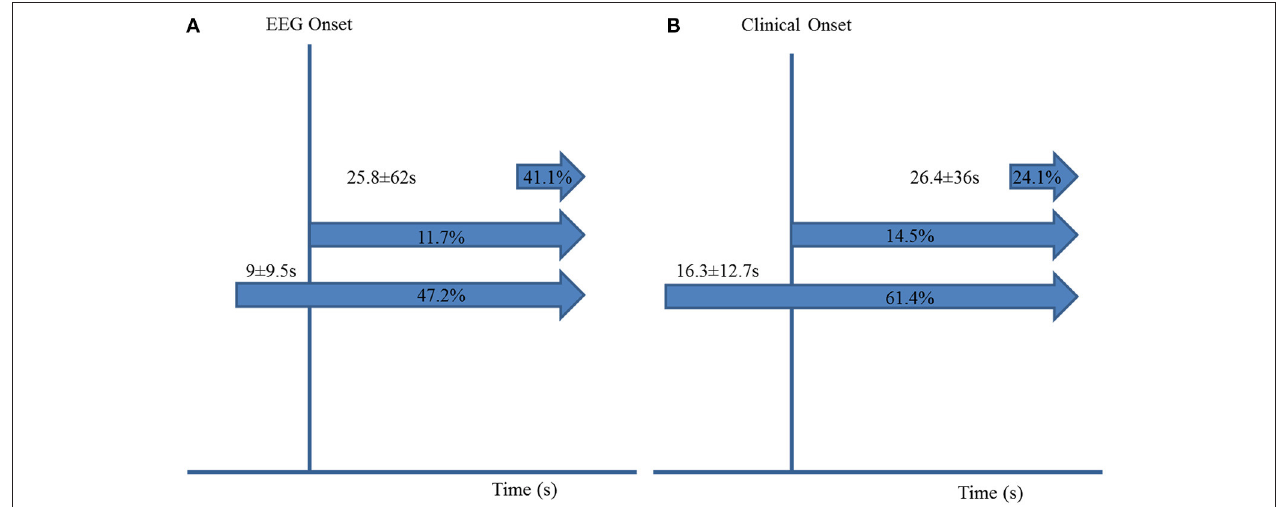
FIGURE 1 | Ictal central apnea (ICA) timing with respect to EEG onset (A) and clinical onset (B)